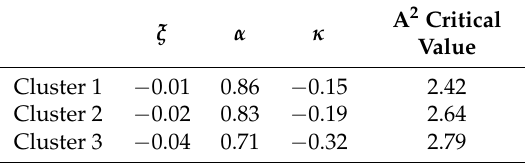
Figure 3. Left panels: Gumbel plot—Continuous black lines represent fitted regional quantile functions, grey points with lines are scaled deficit volumes with probabilities calculated using plotting position, dashed lines highlight discordant catchments; Right panels: Discordance measure showing ratio between coefficient of L-variation and L-skewness, discordant ratios lie outside the notional ellipsis (critical value) that would be drawn around the concordant values. Table 4. Fitted regional parameters with estimated regional A 2 critical